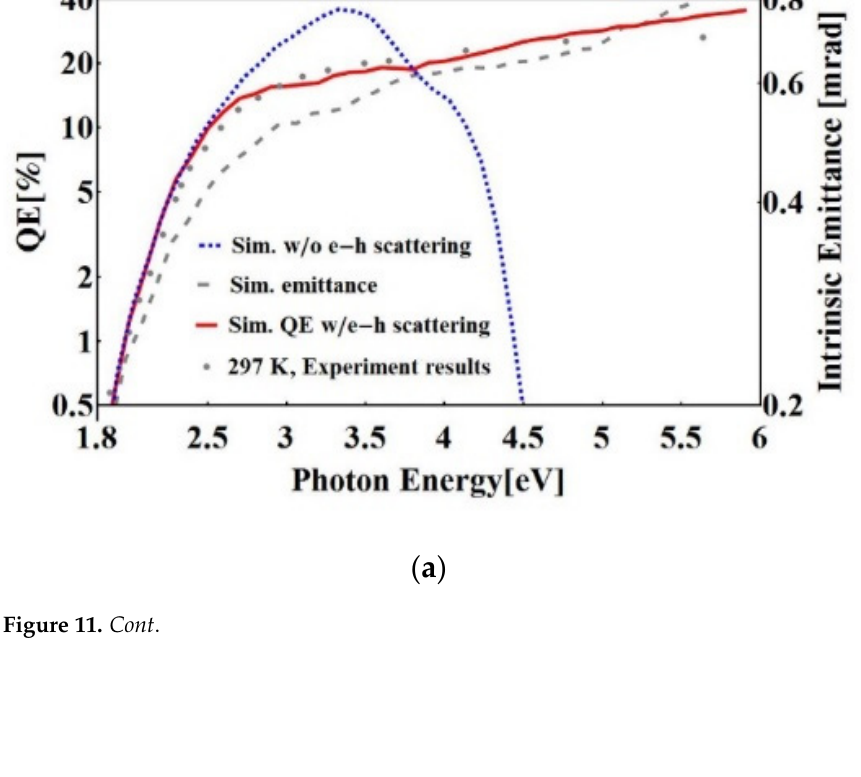
Figure 10. ( top ) The histogram of the electron-energy distribution in the conduction band excited by 2.32 eV laser photons at room temperature. The Y-axis is the probability distribution of electrons at different energies. ( bottom ) The longitudinal distribution of excited electrons along the cathode’s thickness (40 nm) with exponential decay [55].